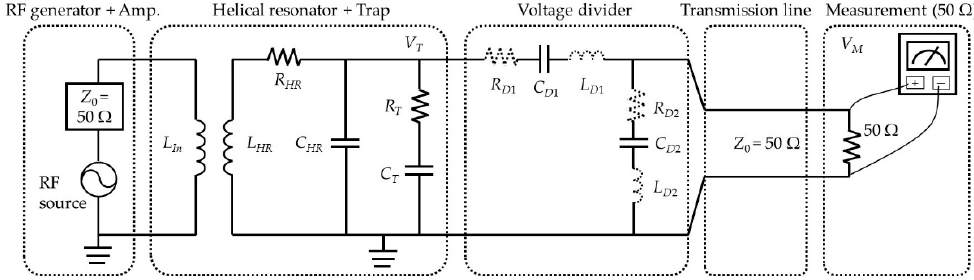
Figure 5. Equivalent RF circuit model of our ion trap setup with a helical resonator, a trap, and measurement setup for the RF voltage amplified by a helical resonator using a voltage divider.